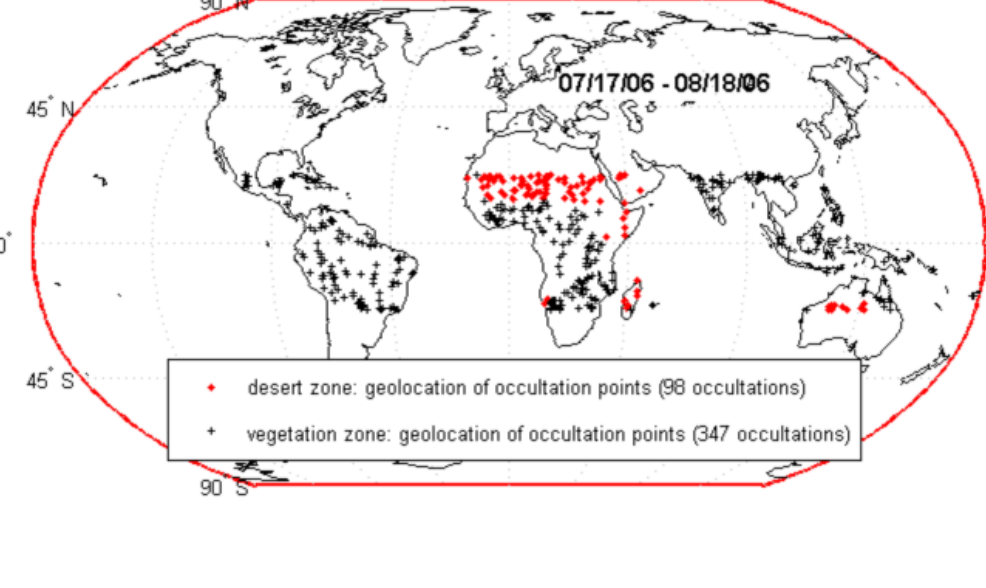
Figure 1. Distribution of FORMOSAT-3/COSMIC GPS occultation employed in the neural